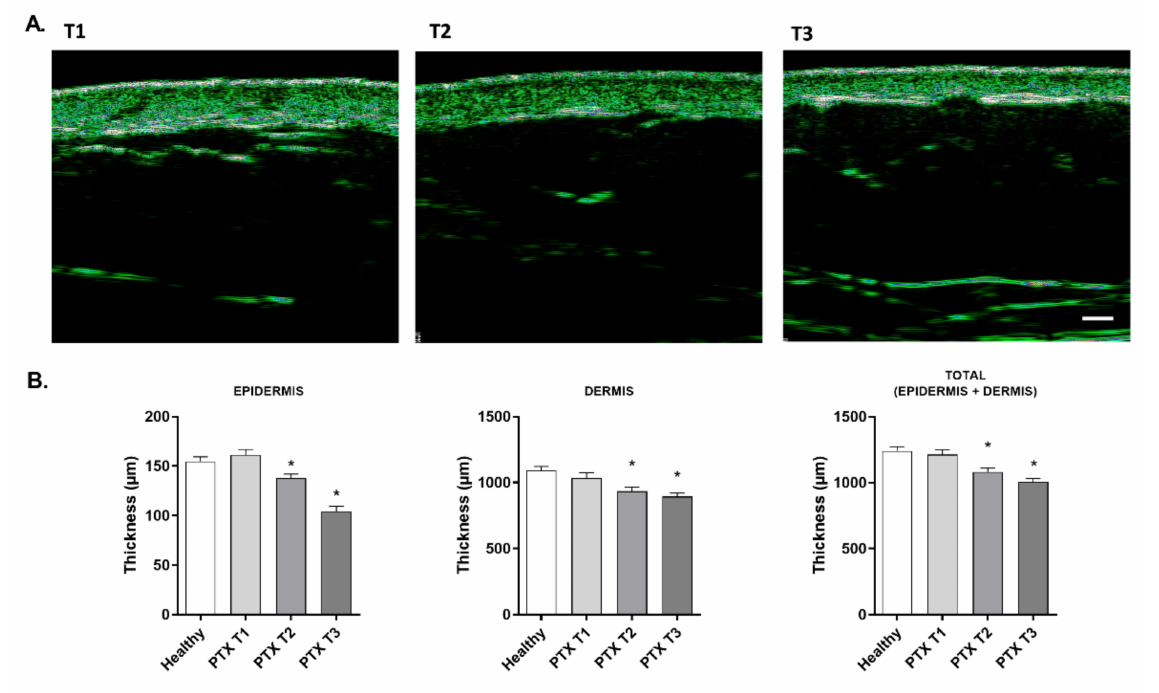
Figure 6. Paclitaxel reduces skin thickness in oncologic patients. ( A ) Representative ultrasound images of the skin thickness obtained during treatment with PTX in 20 oncologic patients before (T1), during (T2), and after (T3) treatment. Images were obtained with Ultrascan ® UC22. Scale bar 1 mm. ( B ) Epidermis, dermis, and total skin thickness measured in 20 oncologic patients under PTX treatment at timepoints T1, T2, and T3, and in 20 healthy subjects as a control group. Measurements were conducted on the forearm with Ultrascan ® UC22. Results are expressed as the mean ± standard deviation of at least 3 measurements each time ( n = 20); * p < 0.05 vs.